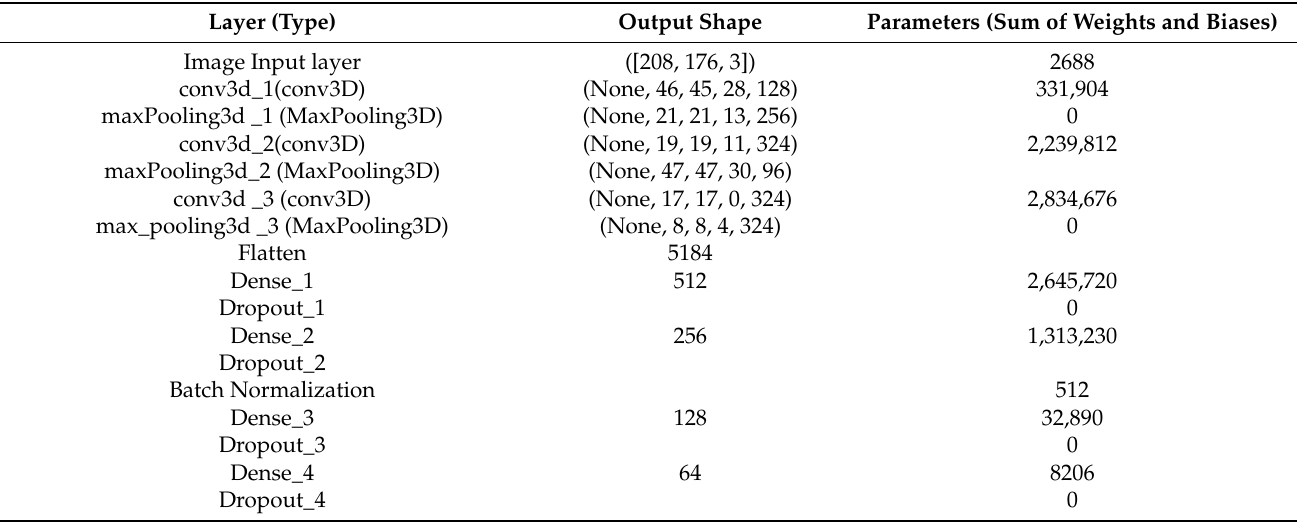
Table 3. Specifications of the designed model’s